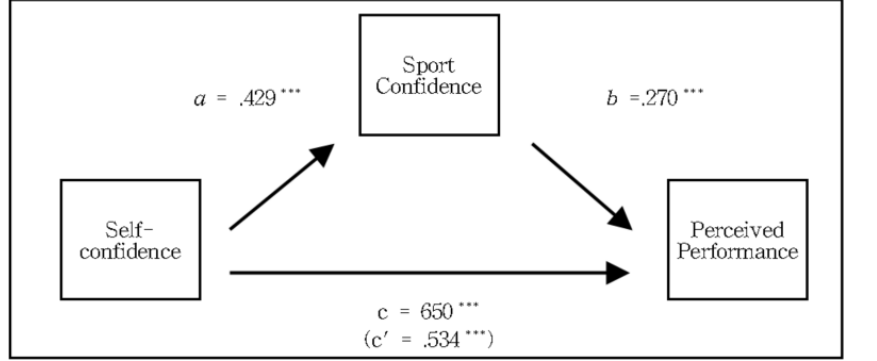
Figure 2. Mediating effect of sports confidence on the relationship between somatic anxiety and perceived performance. *** p < 0.001.